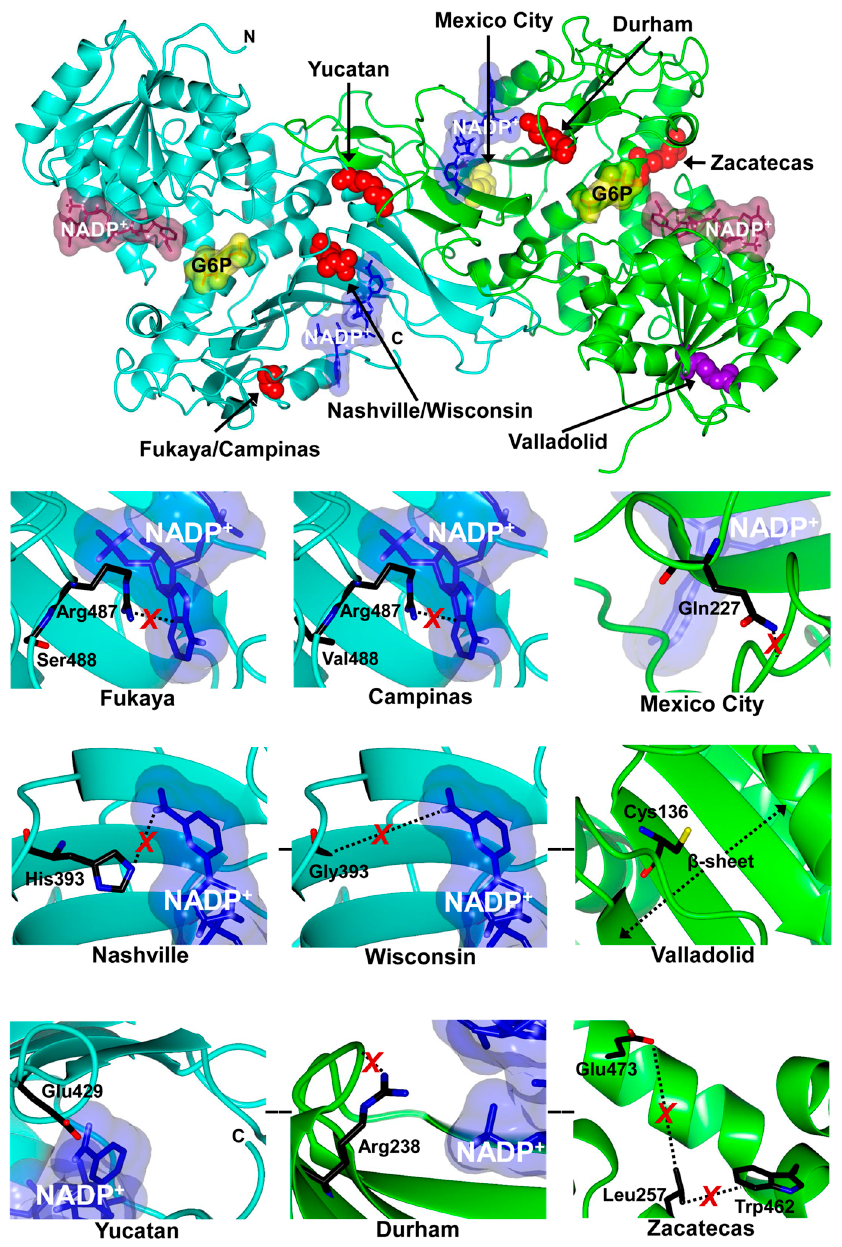
Figure 4. Location of single nucleotide substitutions in G6PD dimer. Insets, close-up of Gly488 mutated either by Ser (Class I, G6PD Fukaya) or Val (Class I, G6PD Campinas). Arg393 replaced by His (G6PD Nashville) or Gly (G6PD Wisconsin). Arg227 replaced by Gln in G6PD Mexico City variant. Arg136 replaced by Cys in G6PD Valladolid variant. Lys429 replaced by Glu in G6PD Yucatan variant. Arg257 replaced by Leu in G6PD Zacatecas variant and Lys238 replaced by Arg in G6PD Durham variant. Mutants of G6PD dimer are indicated by colored spheres: Class I in red, Class II in purple, and Class III in yellow. Mutants in the insets are shown as black cylinders. “X” represents the loss of interaction or clash that is generated in each mutation and affects the native enzyme. Note that all mutants are shown in only one of the monomers of G6PD